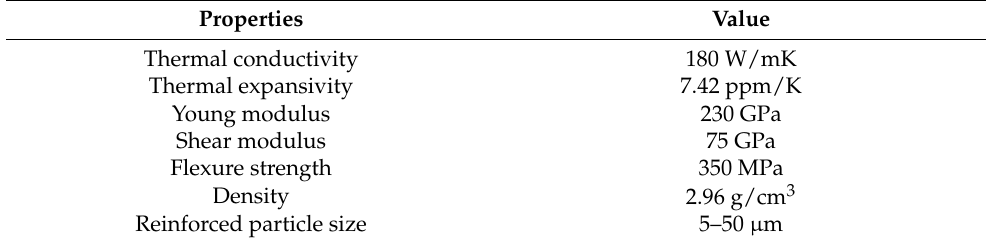
Table 1. The material properties of 65 vol.% SiCp/Al composite.